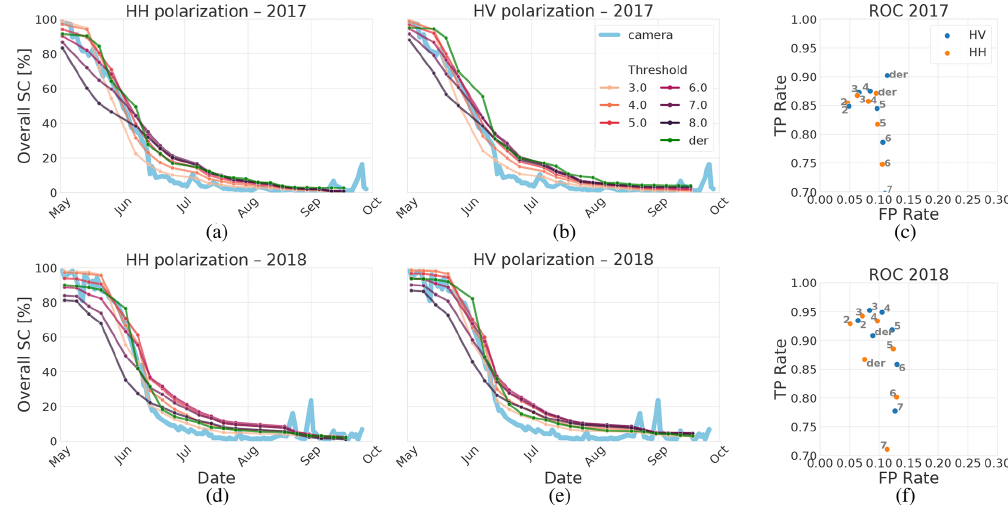
Figure 9. (a, b, d, e) Seasonal development of overall snow cover and (c, f) receiver operator characteristic (ROC) of